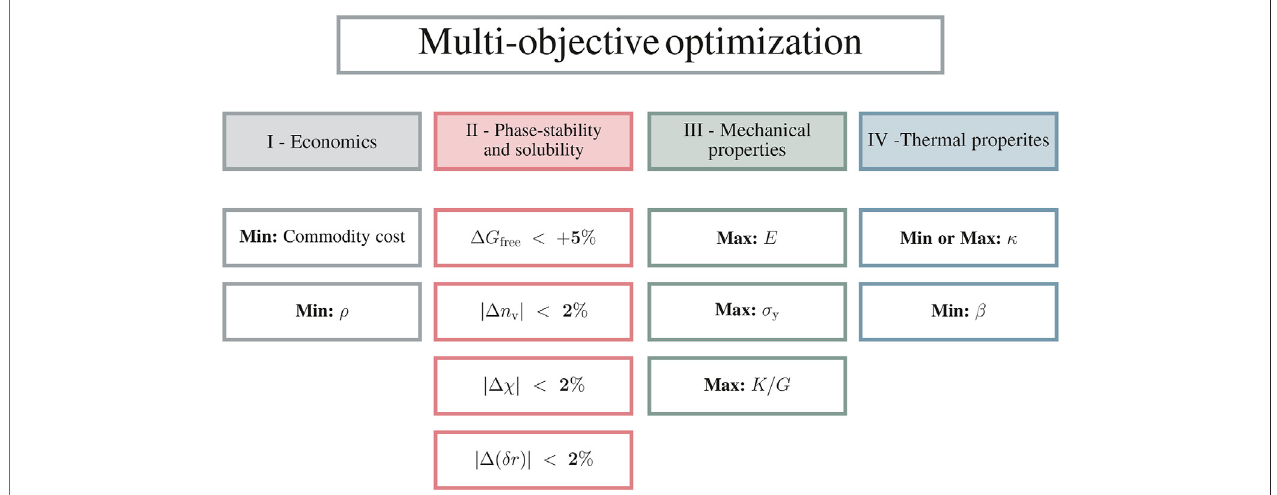
FIGURE1| Schematic illustration ofmulti-objective optimizationforthermalinsulationand heatsinks,operating at high-stress andhigh-temperature. Abbreviation list: ρ :Soliddensity, G free :Gibbs freeenergy, n v :Valence electron concentration, χ :Mullikenelectronegativity, δ r :Atomic-sizemismatchparameter, E :Young ’ smodulus, κ : Thermal conductivity, β : Thermal expansion coef fi σ y : Yield strength, K : Bulk modulus, G : Shear modulus,